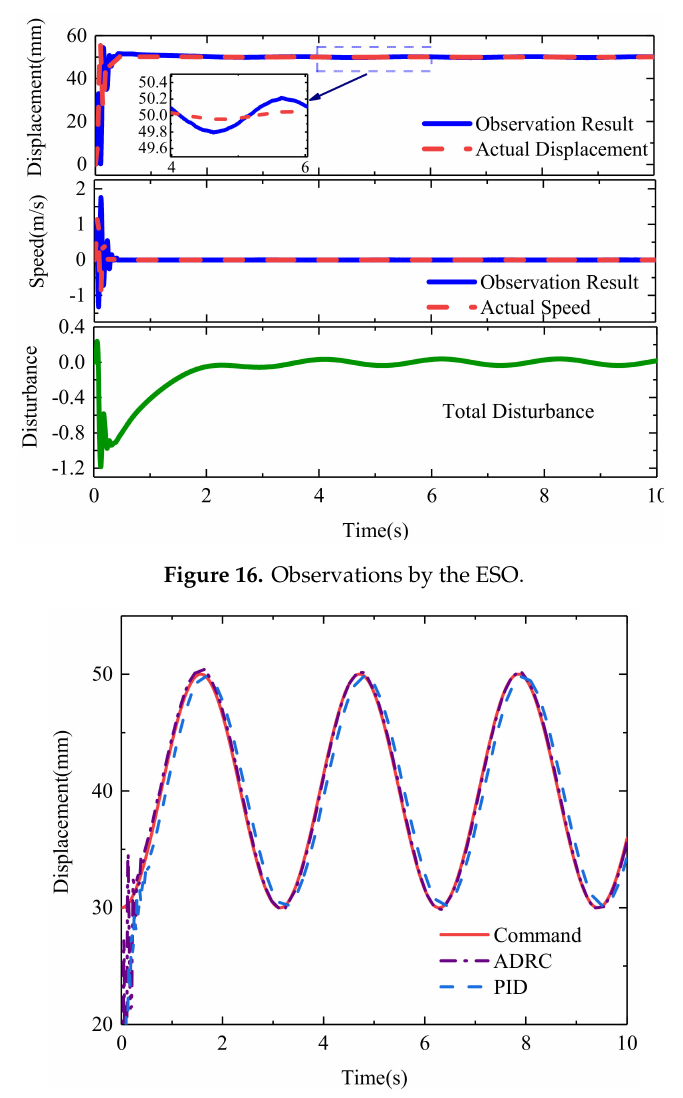
Figure 17. Sinusoidal response.